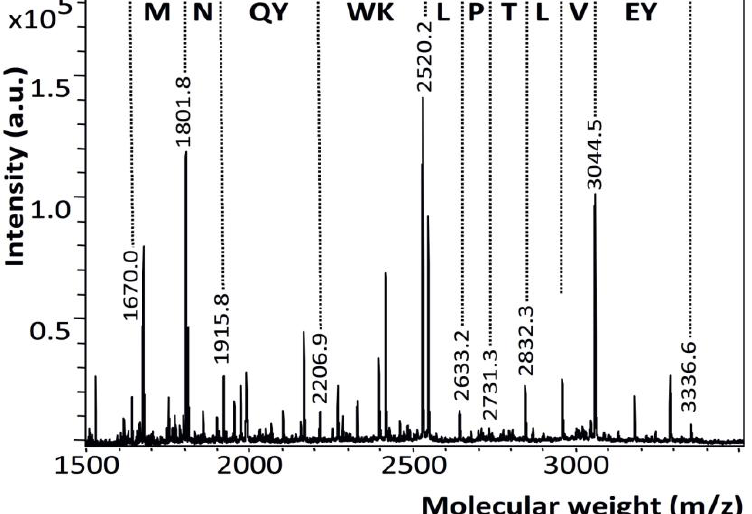
Figure 4. MALDI-ISD of EMD revealed fragments with the sequence YEVLTPLKWYQNM corresponding to the amino acid stretch